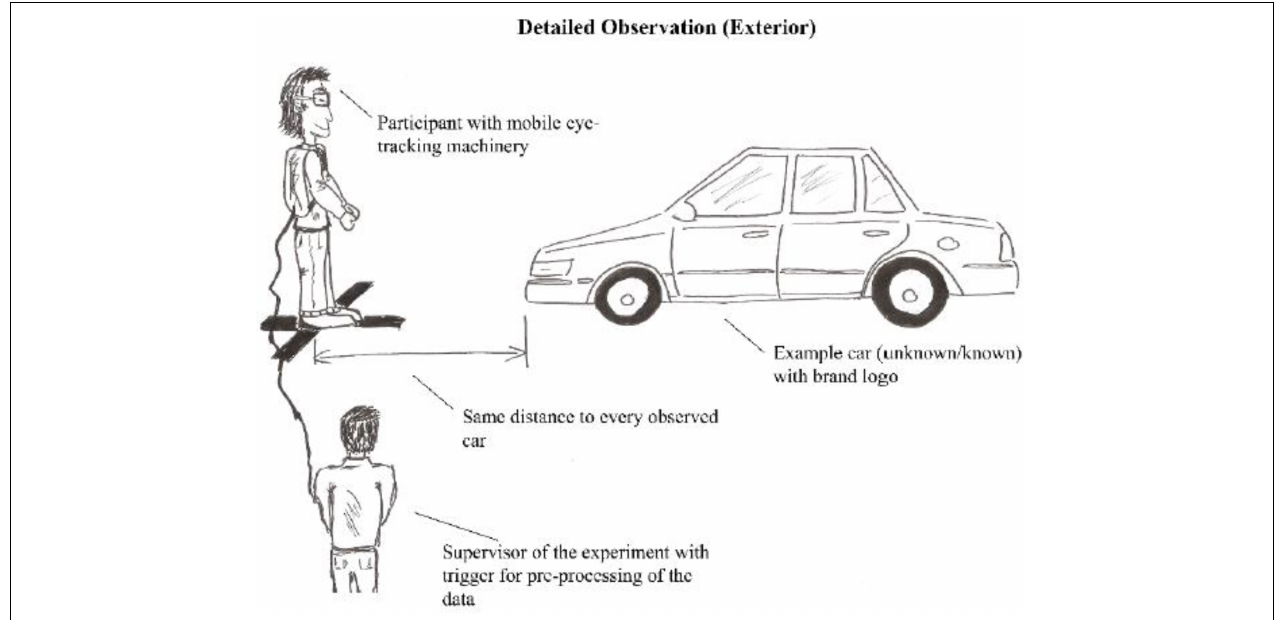
FIGURE 2 | Second phase of the experimental setup (own illustration).